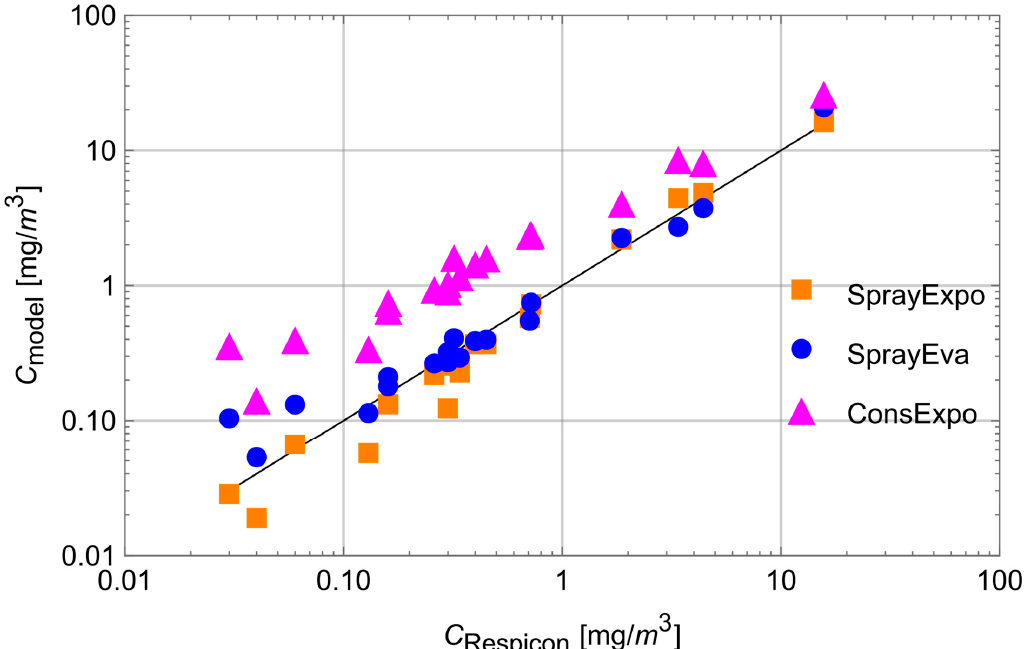
Figure 5. Measured data vs. SprayExpo, ConsExpo, and SprayEva estimates of aerosol exposure. Looking at the deviations between the model values and the Respicon measurements, significant differences between the three models can be observed. For SprayExpo, underestimations are found only at low concentrations below 0.5 mg/m 3 . In contrast, SprayEva tends to overestimate exposure below 0.1 mg/m 3 . This partial lack of agreement is also confirmed numerically by the absolute and relative biases calculated according to Hornung [32], who defined bias as the mean difference between predicted estimates and measured exposure on a logarithmic scale. While the overall bias SprayExpo = − 0.13 and the relative bias SprayExpo = − 12.6% of SprayExpo were slightly negative, a positive bias SprayEva = 0.18 and relative bias SprayExpo = 19.6% was found for SprayEva. At the same time, Pearson correlation coefficients between the measurement results and tool estimates were r SprayExpo = 0.998 and r SrayEva = 0.992, demonstrating excellent correlation. Although the correlation coefficient of ConsExpo was excellent as well (r ConsExpo = 0.994), for some experiments, the model estimates deviated considerably from the measurement results. It seems that overestimation increases with decreasing concentrations. This visually apparent trend toward overestimation was also confirmed numerically by the overall bias (bias ConsExpo = 1.31) and the relative bias (rel.bias ConsExpo = 269.6%). While the experimental and measurement conditions were appropriate for the Respicon aerosol measurements, this was only partially the case for the water vapour concentration measurements. Firstly, the accuracy of the hygrometer used was comparatively low (+/ − 5%), and secondly, the atmospheric pressure was not measured; that is needed for the calculation of the mass concentrations. As a substitute, the mean atmospheric pressure of 101325 Pa was therefore used for the calculations. That is, weather-related changes in air pressure are not taken into account in the calculations. Figure 6 shows the scatter plot of the water vapour measurements versus the model estimates for SprayEva only; vapour exposure was out of the scope of the SprayExpo and ConsExpo spray models.